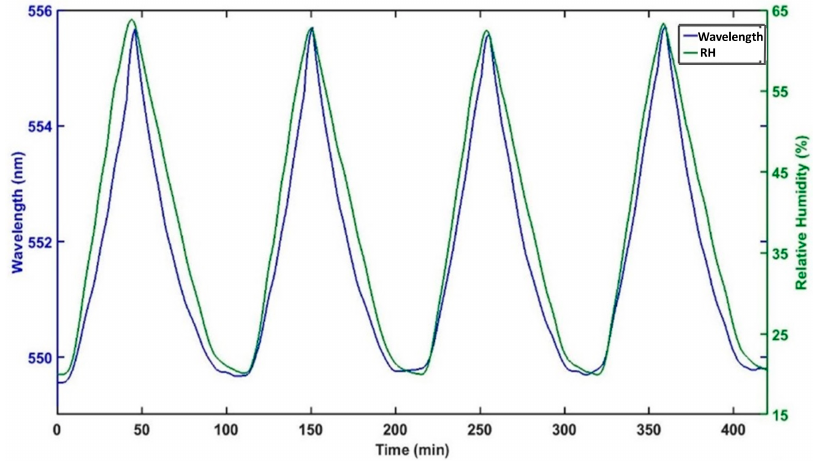
Figure 9. Measured reflected wavelength and RH plotted as a function of time for device D2.